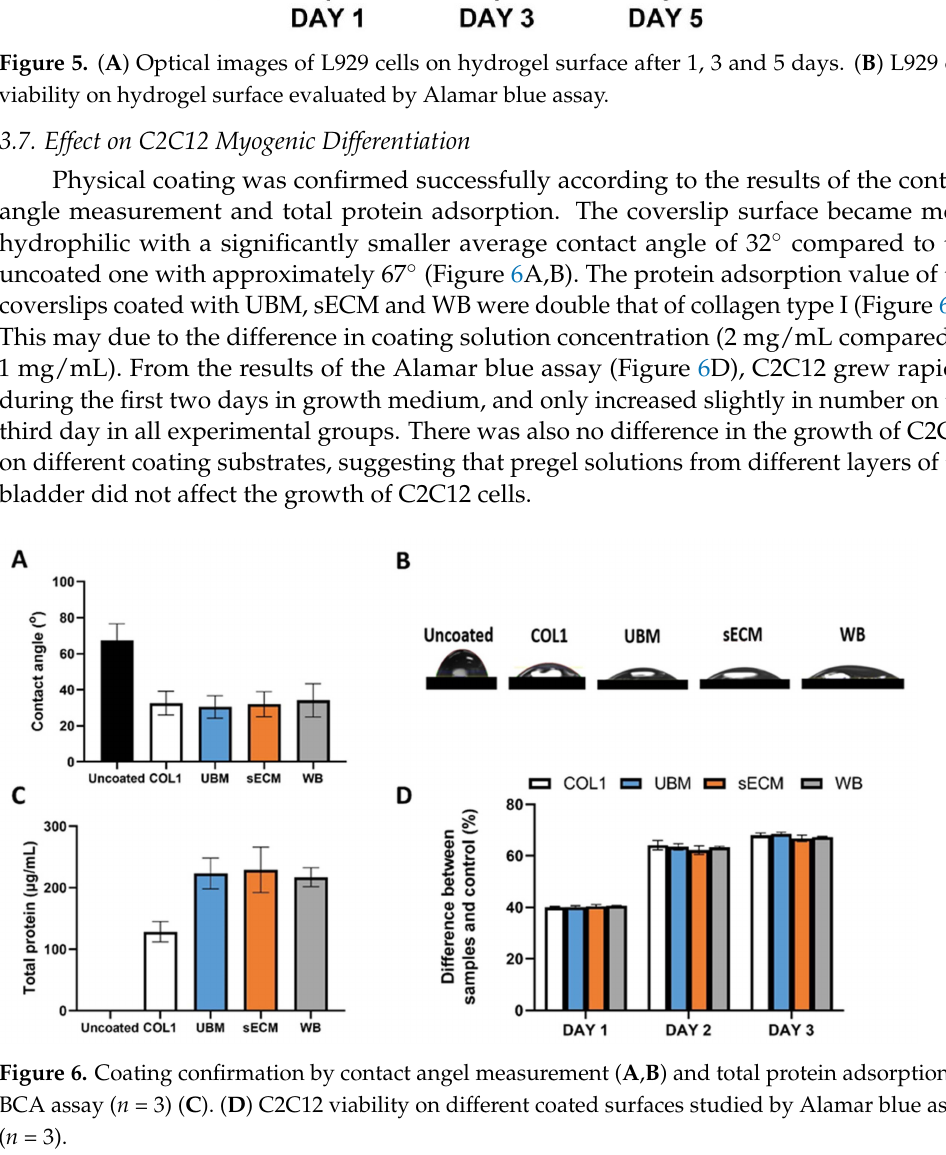
Figure 6. Coating confirmation by contact angel measurement ( A , B ) and total protein adsorption by BCA assay ( n = 3) ( C ). ( D ) C2C12 viability on different coated surfaces studied by Alamar blue assay ( n = 3).